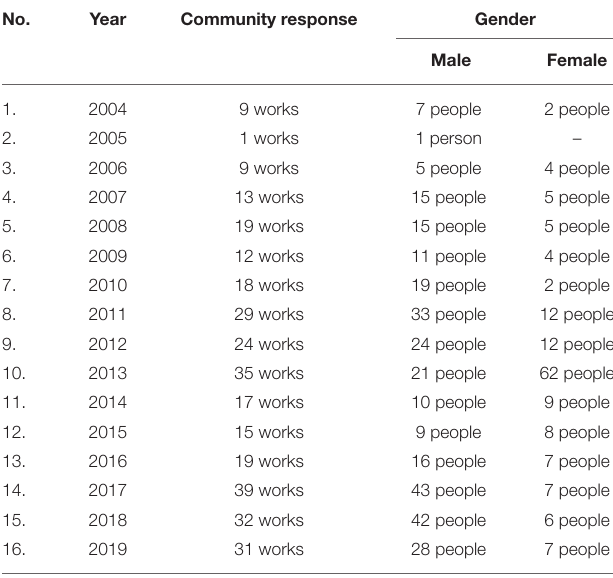
TABLE 2 | Community responses to the interaction of innovation in Magelang City in 2004–2019.